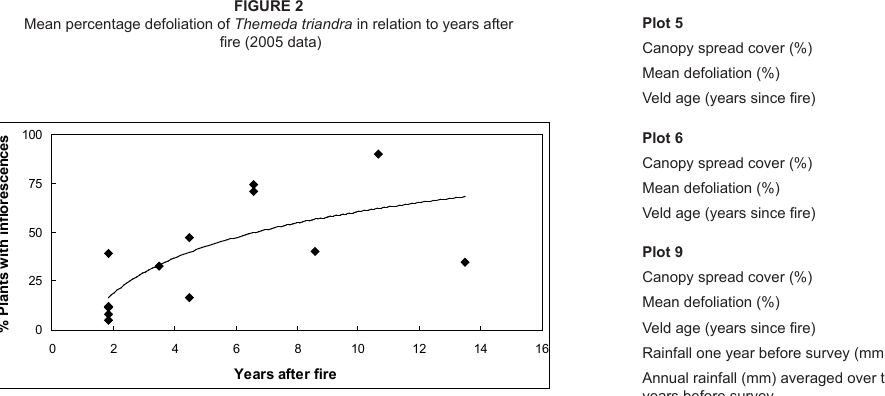
FIGURE 3 Percentage of Themeda triandra tufts bearing inflorescences in relation to years after fire (2005